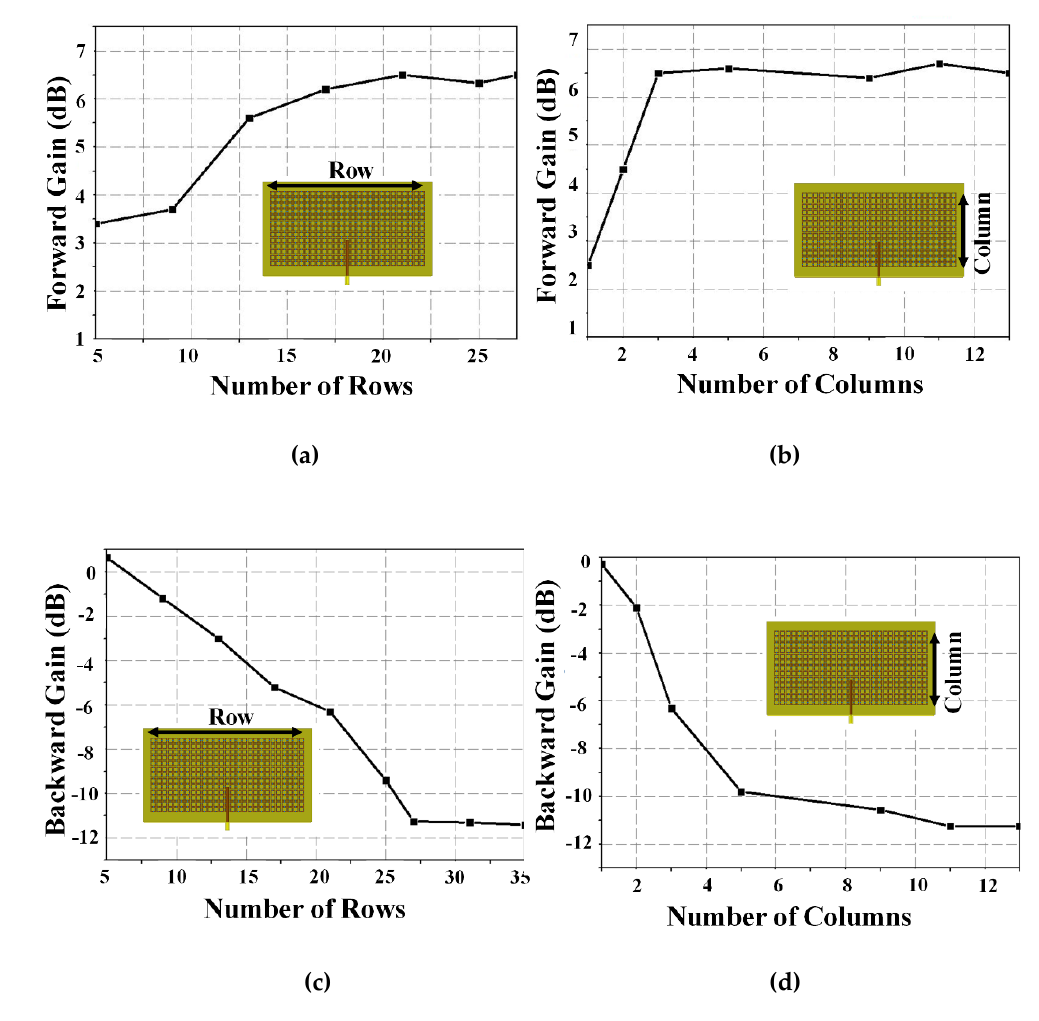
Figure 8. Simulated forward gain ( θ = 0 ◦ ) for the proposed antenna at 2.65 GHz with di ff erent ( a ) rows and ( b ) columns of unit cells. Simulated backward gain ( θ = 180 ◦ ) for the proposed antenna at 2.65 GHz with di ff erent ( c ) rows and ( d ) columns of unit cell.